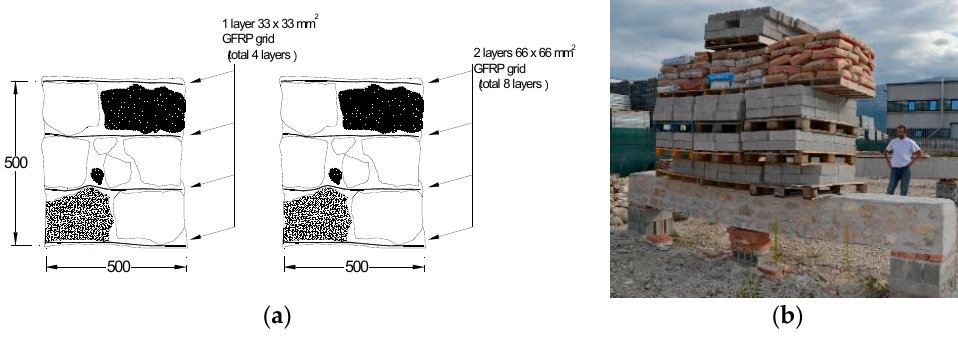
Figure 4. Ring beams under loading: ( a ) grid arrangement for stonemasonry beams; ( b ) P5-G33-V.